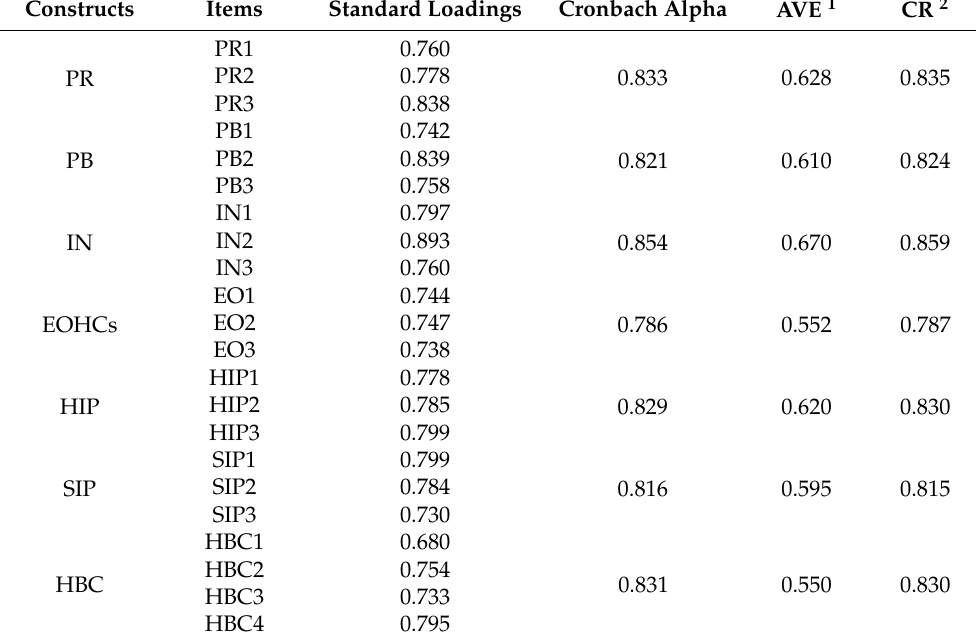
Table 3. Statistical results of the research model. Constructs Items Standard Loadings